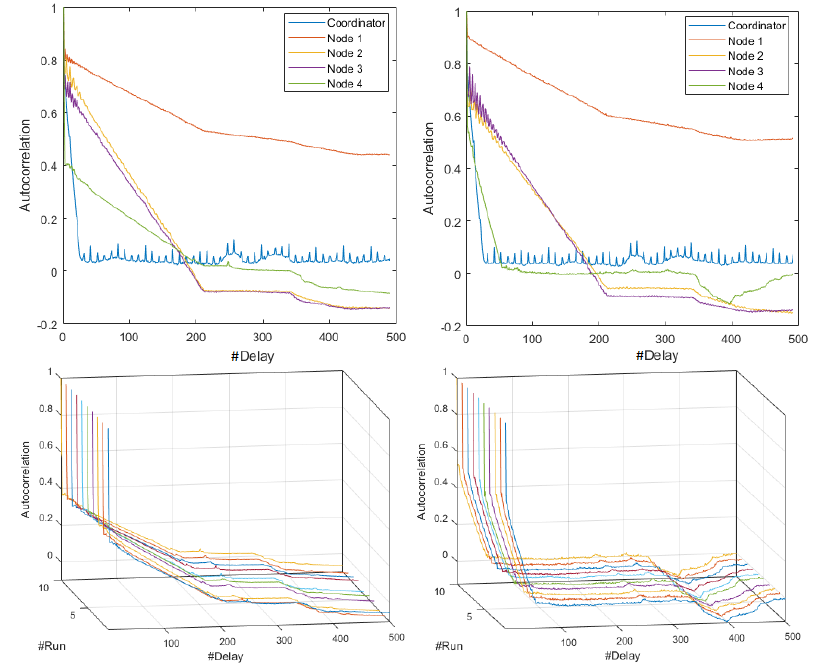
Figure 20. Representative SAF for WiFi network: ( Left ) 9600 bauds; ( Right ) 57,600 bauds; ( Top ) time series for Realizations 6 and 7; and ( Bottom ) M-mode of Sensor Node